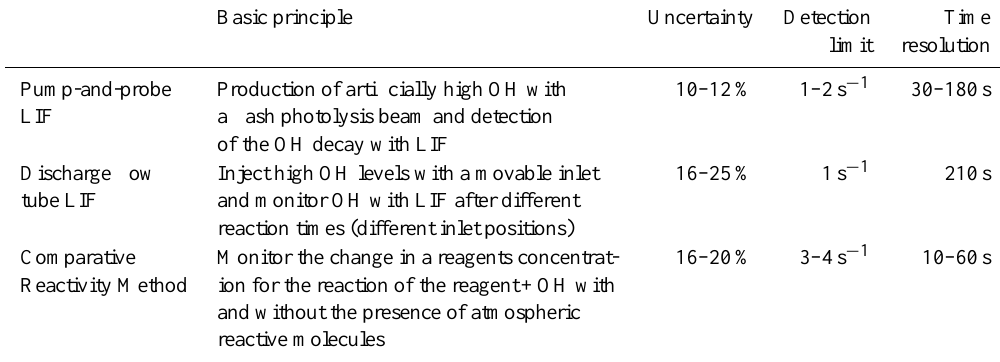
Table 1. Three basic principles for direct total OH reactivity measurements, the uncertainties, detection limit and time